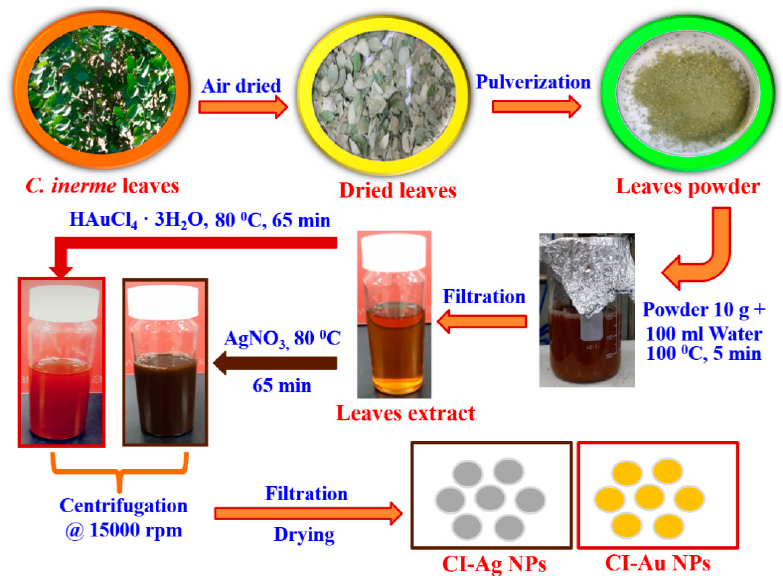
Figure 1. Schematic showing extract preparation and green synthesis of CI-Au and CI-Ag nanoparticles (NPs) using aqueous leaves extract of Clerodendrum inerme . (NPs) using aqueous leaves extract of Clerodendrum inerme